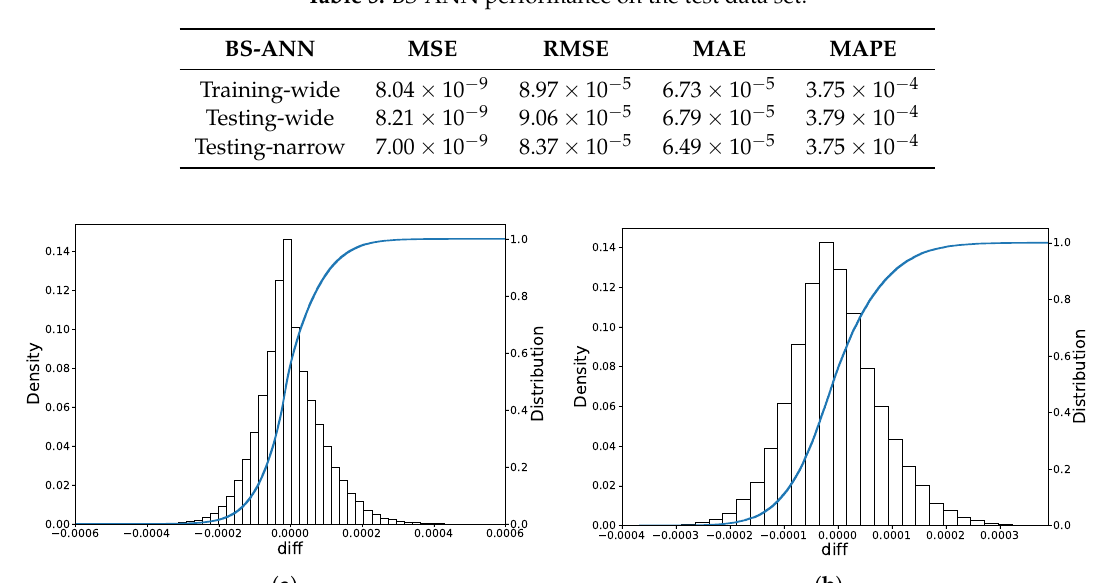
Table 5. BS-ANN performance on the test data set.